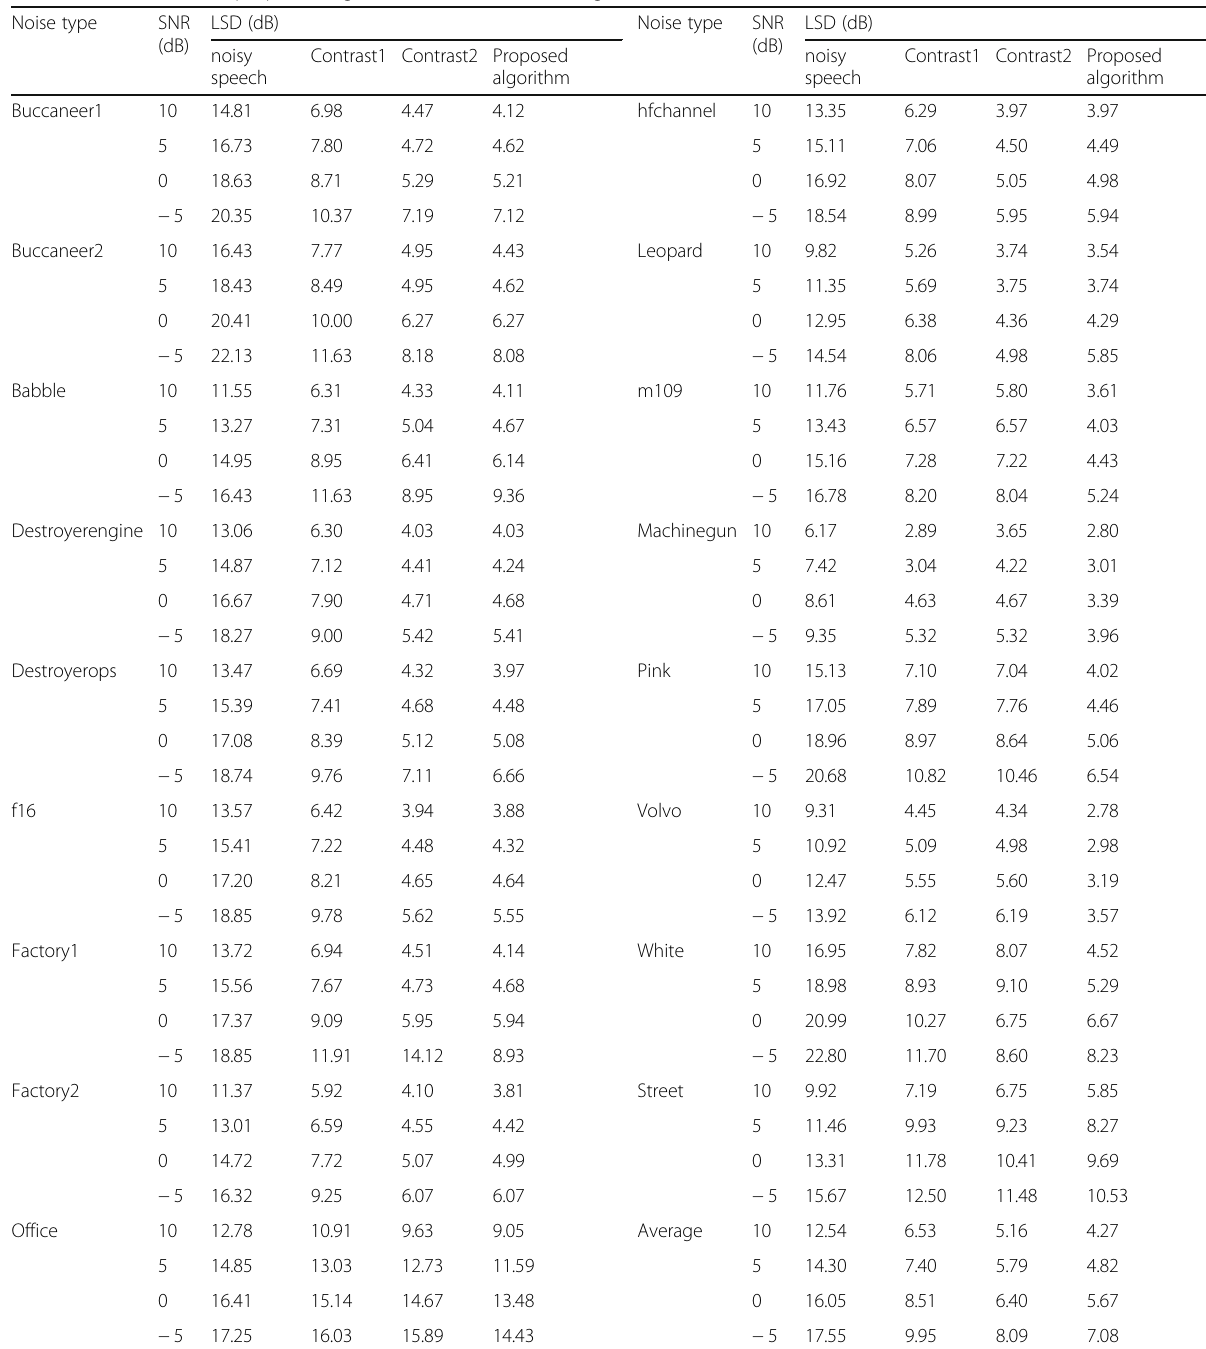
Table 2 The LSD of the proposed algorithm and the contrast algorithm Noise